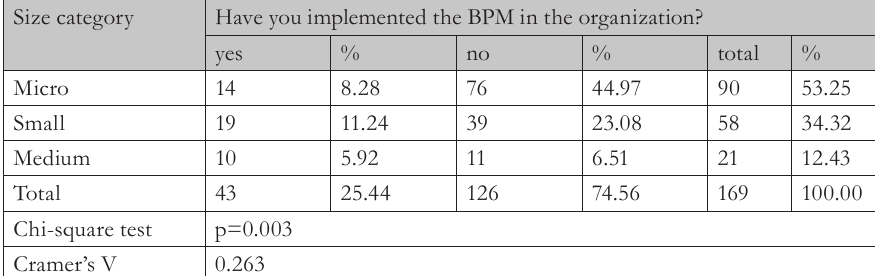
Tab. 1 – Classification of SMEs in terms of their size and use of BPM. Source: own research